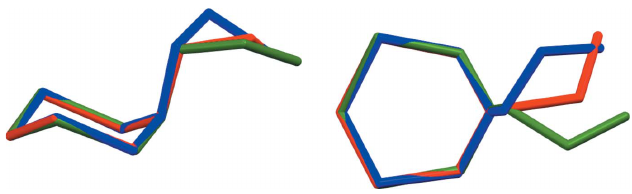
Figure 3 An overlay of the two polymorphs of MEA-dithiazine (red: form II; blue form I) and of the cation of the chloride salt (green). Overlays are based on a least-squares fit of the dithiazine ring atoms.